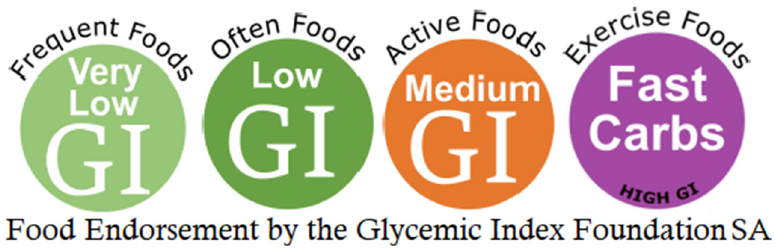
Figure 2. Glycaemic Index Foundation of South Africa’s GI